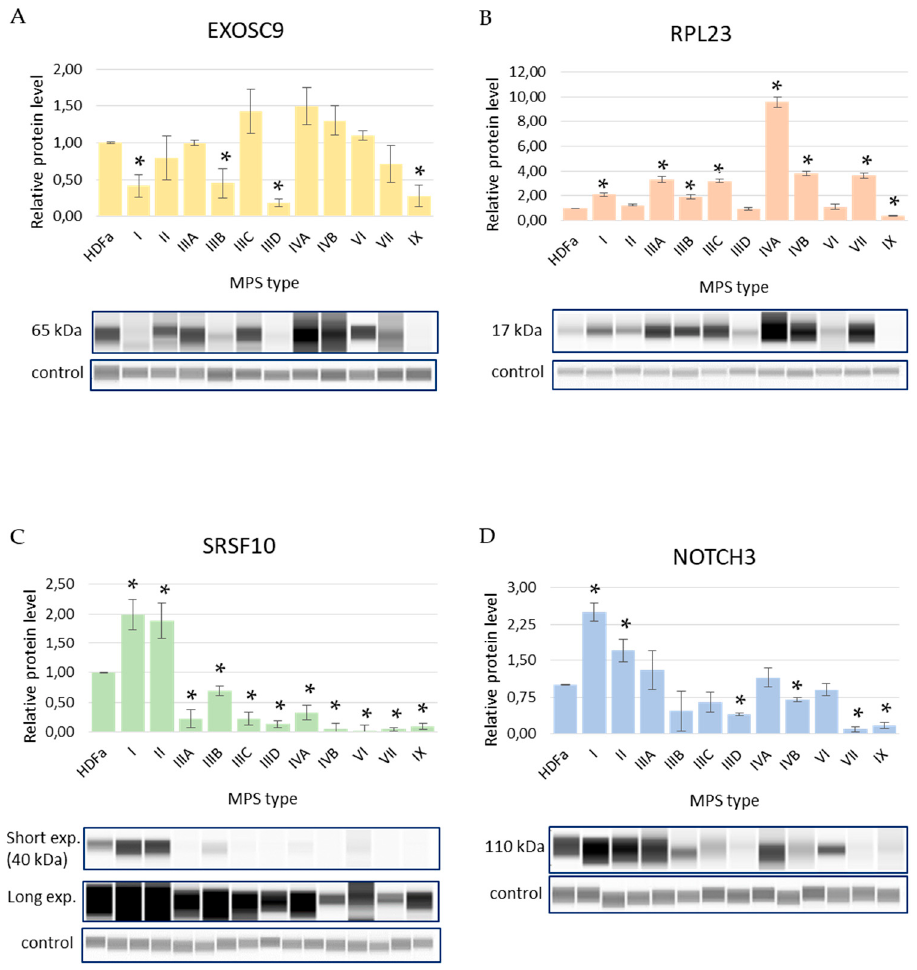
Figure 4. Levels of selected proteins (EXOSC9, panel ( A ); RPL23, panel ( B ); SRSF10, panel ( C ); NOTCH3, panel ( D )) in fibroblasts of different types of MPS relative to control HDFa cells. The lower parts of each panel represent representative fragments of the blots (‘control’ represents loading control; in panel ( C ), short and long exposures are shown due to the low-level signal under standard conditions), and the upper parts demonstrate the quantification of the results. The results indicated by the columns are the mean values from three independent experiments with error bars representing SD. Statistically significant differences relative to the HDFa control ( p < 0.05) are indicated by asterisks (*).